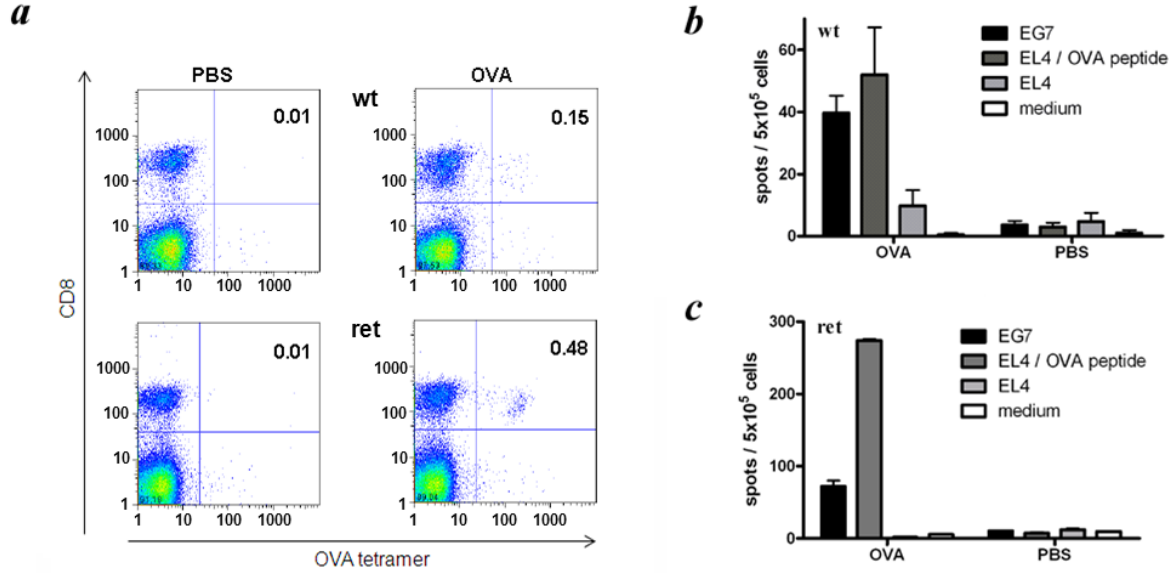
Figure 4. Induction of OVA-specific CD8 + T cell responses in ret transgenic mice. Tumor free ret transgenic mice (ret) or non-transgenic littermates (wt) were immunized with expression plasmid pcDNA3.1-OVA. Control mice were injected with PBS. Frequencies and functional activities of OVA-specific spleen CD8 + T cells were analyzed ex vivo by tetramer staining ( a ) and IFN- γ ELISPOT assays ( b , c ); ( a ). Representative dot plots for tetramer staining are shown; ( b , c ). Cumulative data (mean ± SEM; 9–11 mice per group) for IFN- γ secreting CD8 + T cells are presented as numbers of IFN- γ spots among 5 × 10 5